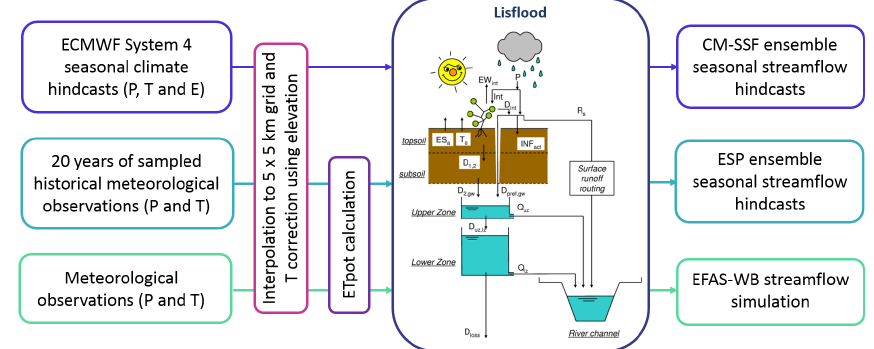
Figure 1. Schematic of the EFAS-WB streamflow simulation and of the CM-SSF and ESP seasonal streamflow hindcast generation, where P is precipitation, T is temperature, E is evaporation and ETpot is potential evapotranspiration. The Lisflood model diagram was taken from Burek et al.